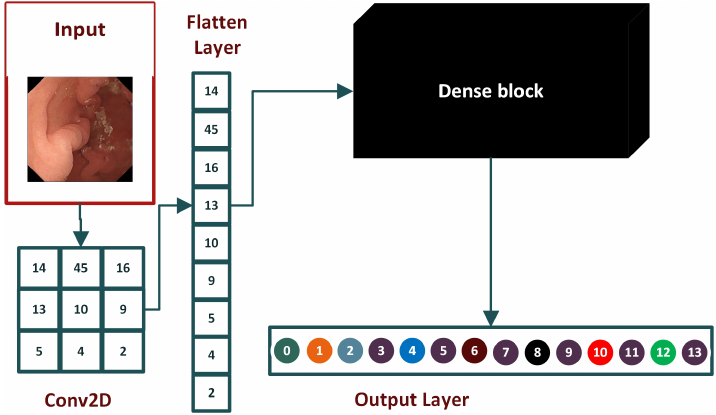
Figure 6. The base architecture of the flattened